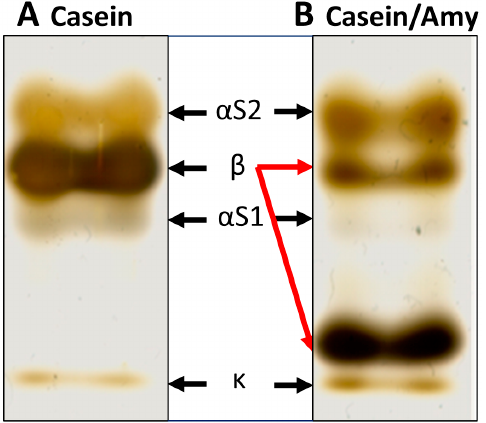
Figure 2. Casein digestion by amylase preparation (silver staining). ( A ) 1D SDS gel of purified casein from cow’s milk. ( B ) After incubation with amylase preparation from B. amyloliquefaciens , mainly the β -casein band, but also the α S1-casein band appear weaker. In addition, another band appears directly above the k-casein band (red arrows).